Question: Write a single sentence explaining what this figure depicts.
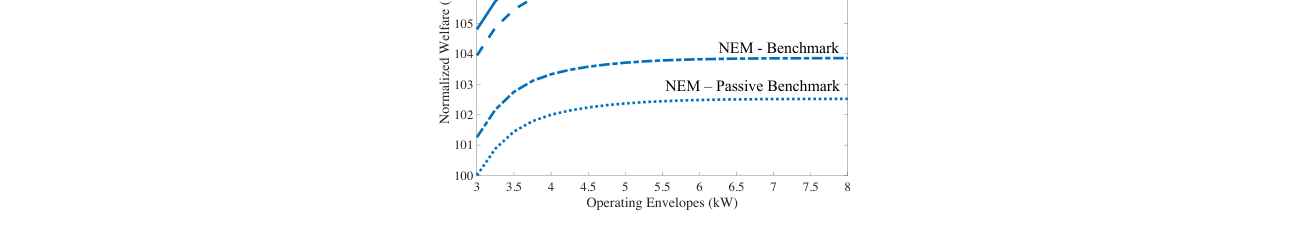
Answer: Normalized average monthly welfare (%) under varying OEs.